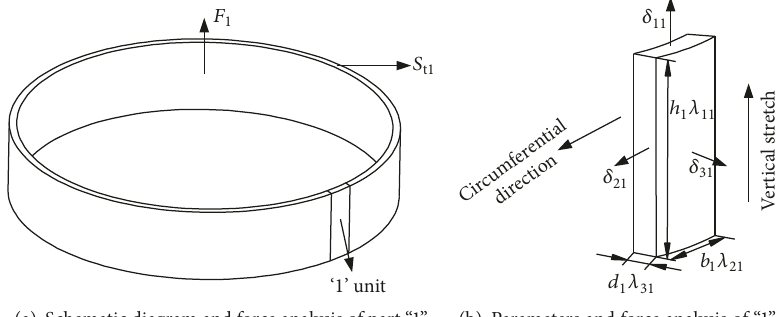
Figure 5: Force analysis of part “1” of the elastomeric diaphragm.